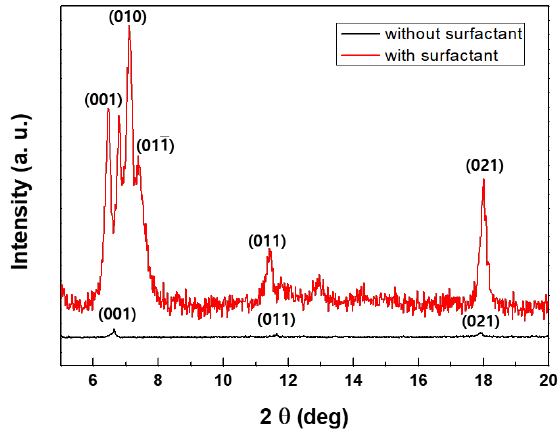
Figure 5. Comparison of X-Ray Diffraction (XRD) spectra of Alq 3 (upper line corresponds to crystal hexagonal column microwires (MWs), lower line indicates amorphous nanoparticles (NPs)).